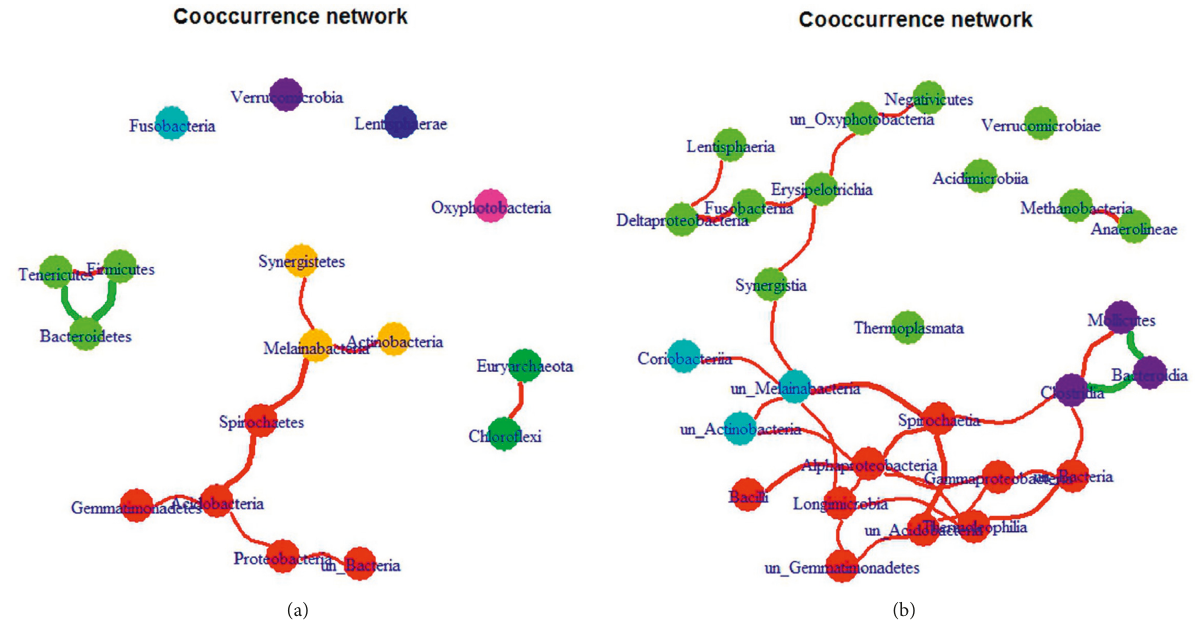
Figure 2: Operational taxonomic unit- (OTU-) based cooccurrence network analyses. The cooccurrence network of gut microbiota was constructed based on the correlation analysis. By applying the modularity scores, the dense communities were identified in graphs at the (a) phylum level and (b) class